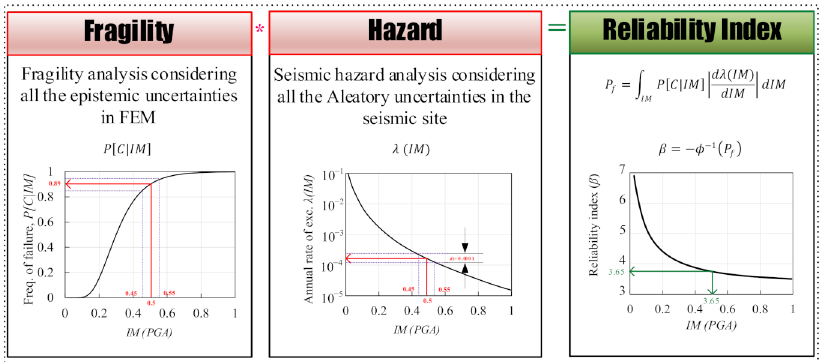
Figure 3. Estimation of reliability index